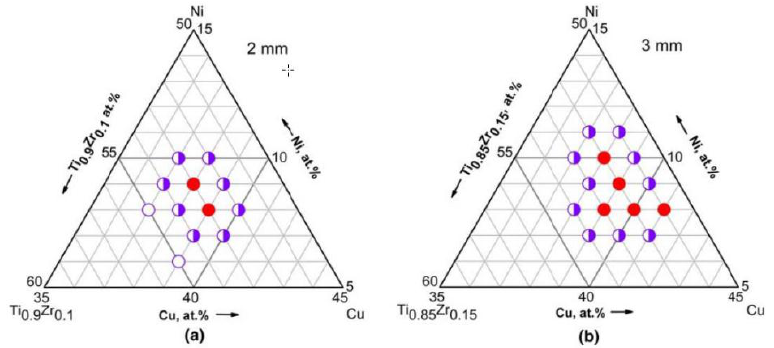
Figure 4. Composition maps of BMG formation in the (Ti 1− x Zr x )–Cu–Ni system. The two panels, (a) and (b), show the BMG-forming composition ranges at two ratios of Ti 1− x Zr x , ( a ) x = 0.1 and ( b ) x = 0.15, for the as-cast rods of 2 and 3 mm in diameter, respectively. Reproduced with permission from [41]. Copyright 2008, Springer.